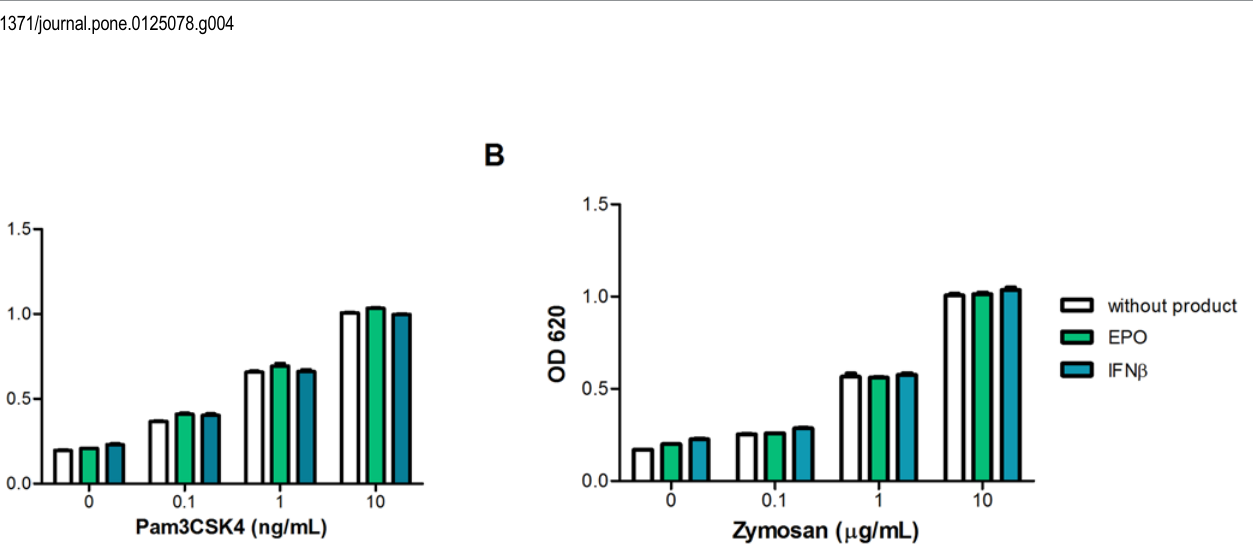
PLOS ONE | DOI:10.1371/journal.pone.0125078 April 22,